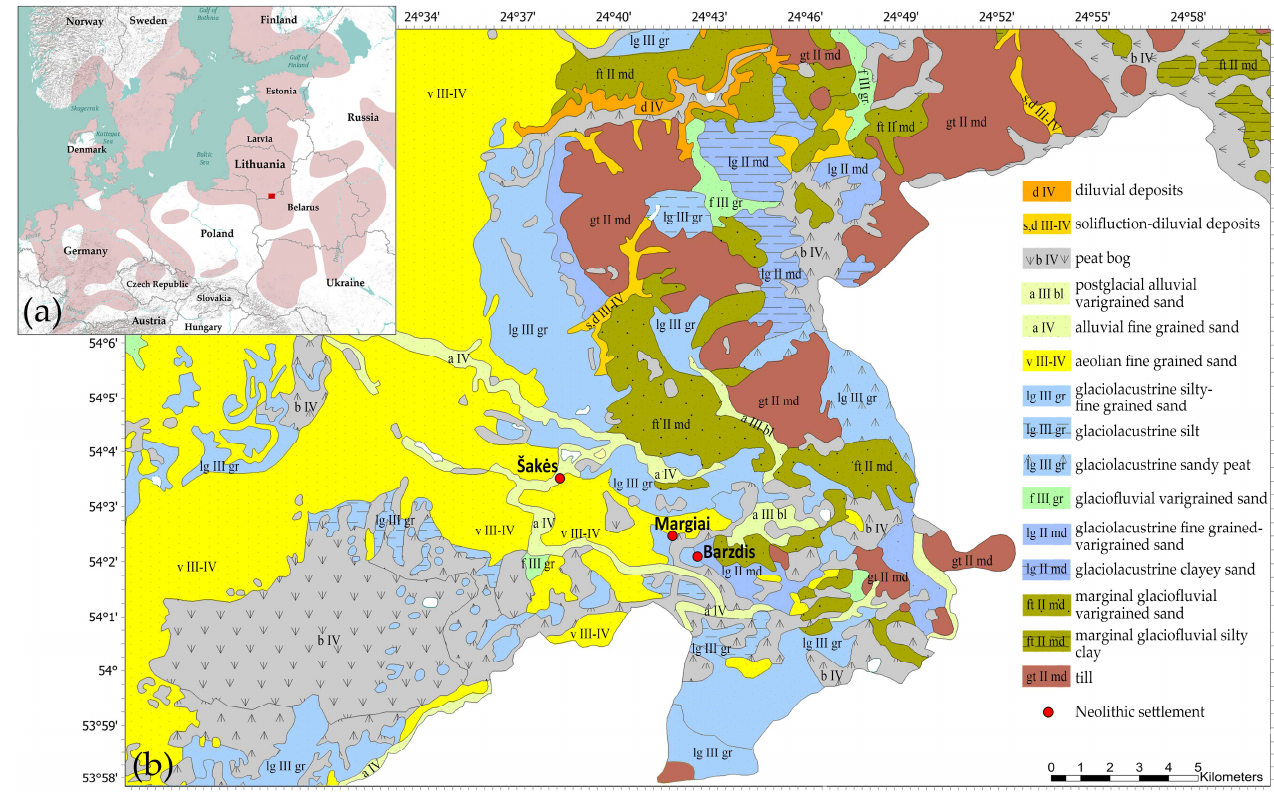
Figure 1. Study area: ( a ) a distribution map of the Corded Ware Culture (pink color) (after [5]) (redrawn from [7], Figure 1), and the location of the study area (red square); ( b ) a geomorphological map of the Dubičiai-Rudnia microregion (Reprinted with permission from [16], © 2022 Lithuanian Geological Survey under Ministry of Environment), and the studied Neolithic settlements.